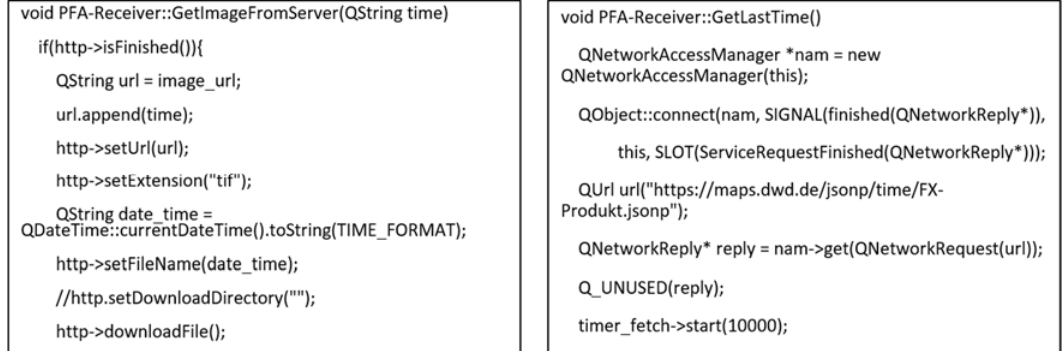
Figure A1. Example of the PFA code for the implementation of the DWD ‐ HTTP request.